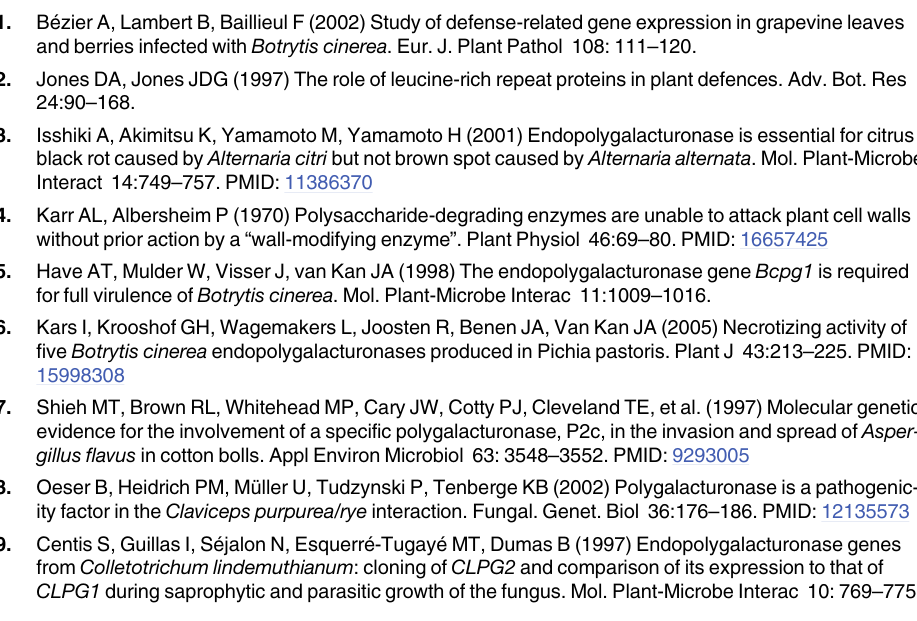
(TIF) S3 Fig. Schematic representation of pCold-TF-CkPGIP1 bacterial expression plasmid. (TIF) S4 Fig. Schematic representation of the plant expression vector pCAMBIA1300-CkPGIP1. (TIF) S5 Fig. Selection and identification of transgenic Arabidopsis. Lines 1 – 14 were genotyped by PCR, and 11 were found to be transgenic. Real-time PCR was then used to measure relative expression of CkPGIP1 . S1 Table. The comparison of all the changes about the complexes before and after optimi- zation. ( A ): before optimization;( B ): after optimization. glob: the binding energy of the solu- tion; aVdWa and rVdW: softened attractive and repulsive van der Waals energy; ACE: atomic contact energy; HB: hydrogen and disulfide